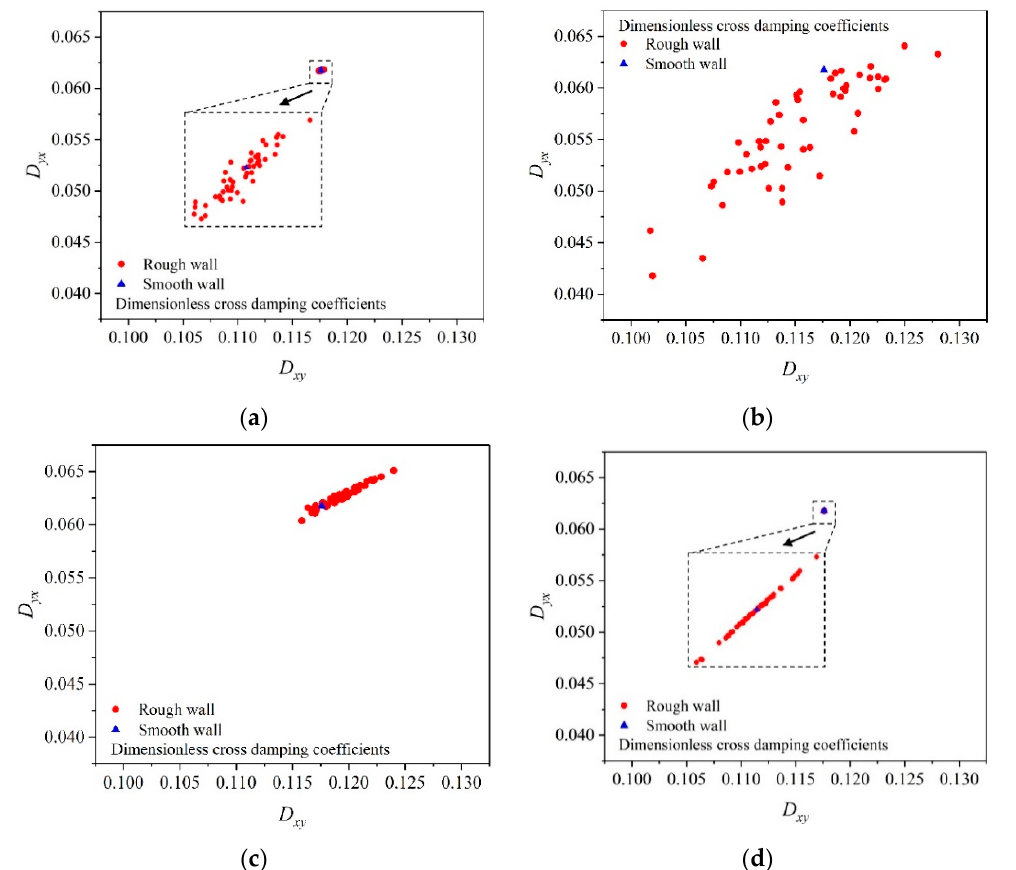
Figure 18. Damping coe ffi cients distribution with wear in circumferential regions. ( a ) circumferential region 3. ( b ) circumferential region 4. ( c ) circumferential region 5. ( d ) circumferential region 6.